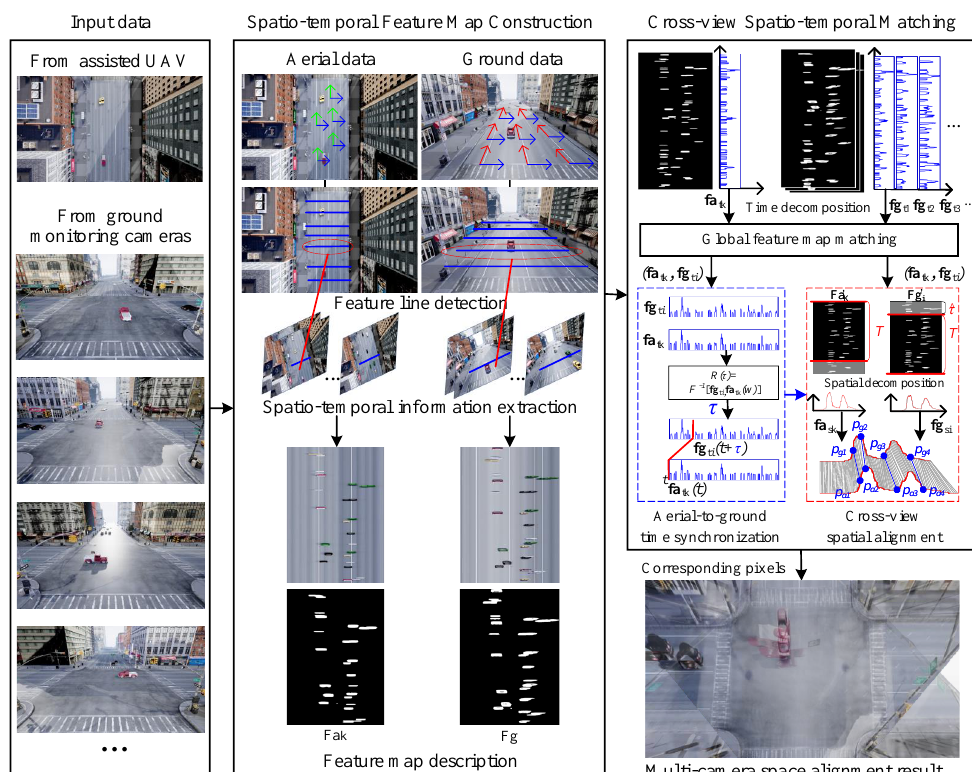
Figure 2. An illustration of the proposed UAV-assisted wide area multi-camera space alignment approach based on spatiotemporal feature map. Our algorithm contains two critical components: spatiotemporal feature map construction to describe the input UAV-assisted aerial data and ground monitoring data and cross-view spatiotemporal matching to mine air-to-ground space correspon- dences. Multiple ground cameras are aligned into one space with UAV-assisted visual